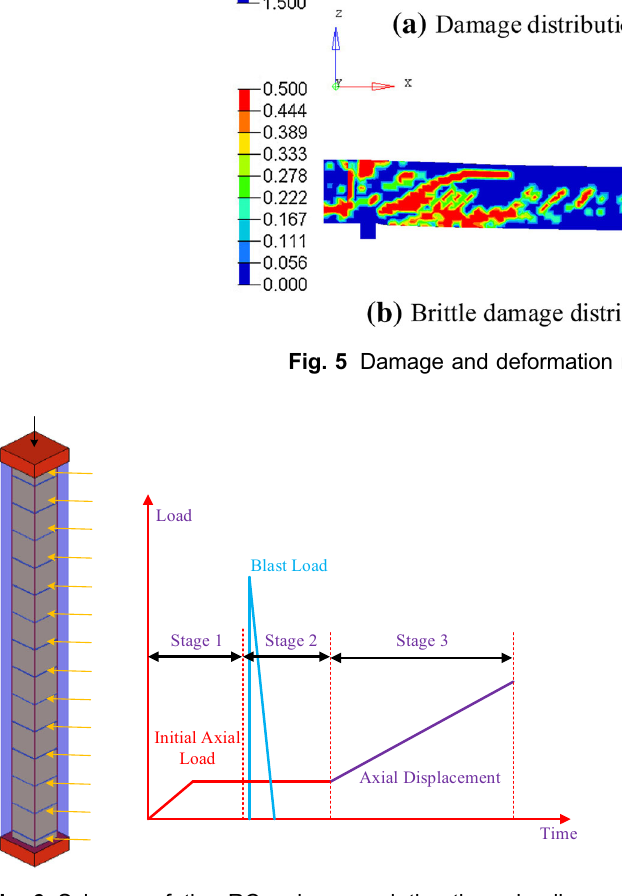
Fig. 6 Scheme of the RC column and the three loading